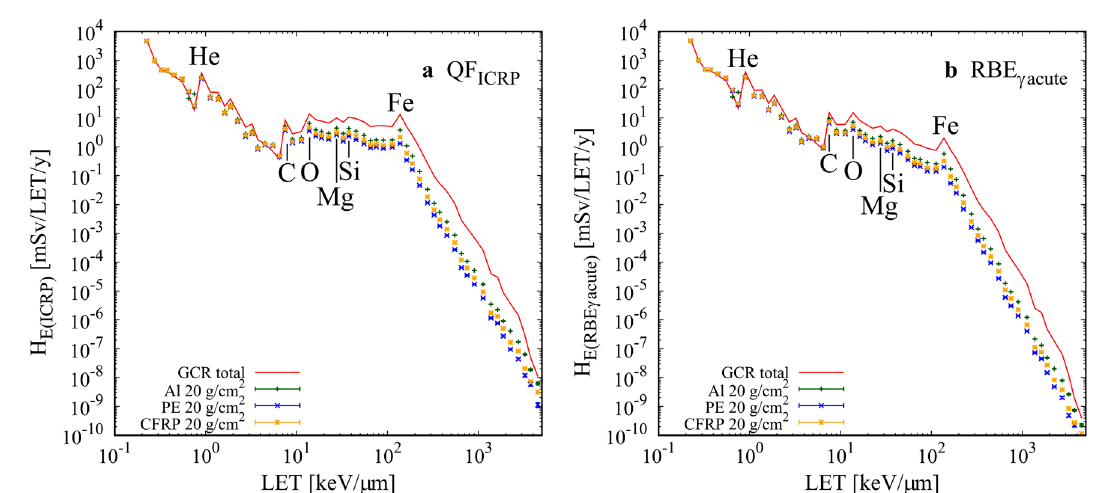
Figure 5. LET dependencies of the effective dose equivalents. ( a ) H E(ICRP) and ( b ) H E(RBEγacute) . Red line denotes total GCR primary particles in the free space. Green, blue, and yellow denote total GCR primary particles with 20 g/cm 2 shielding with Al, PE, and CFRP,